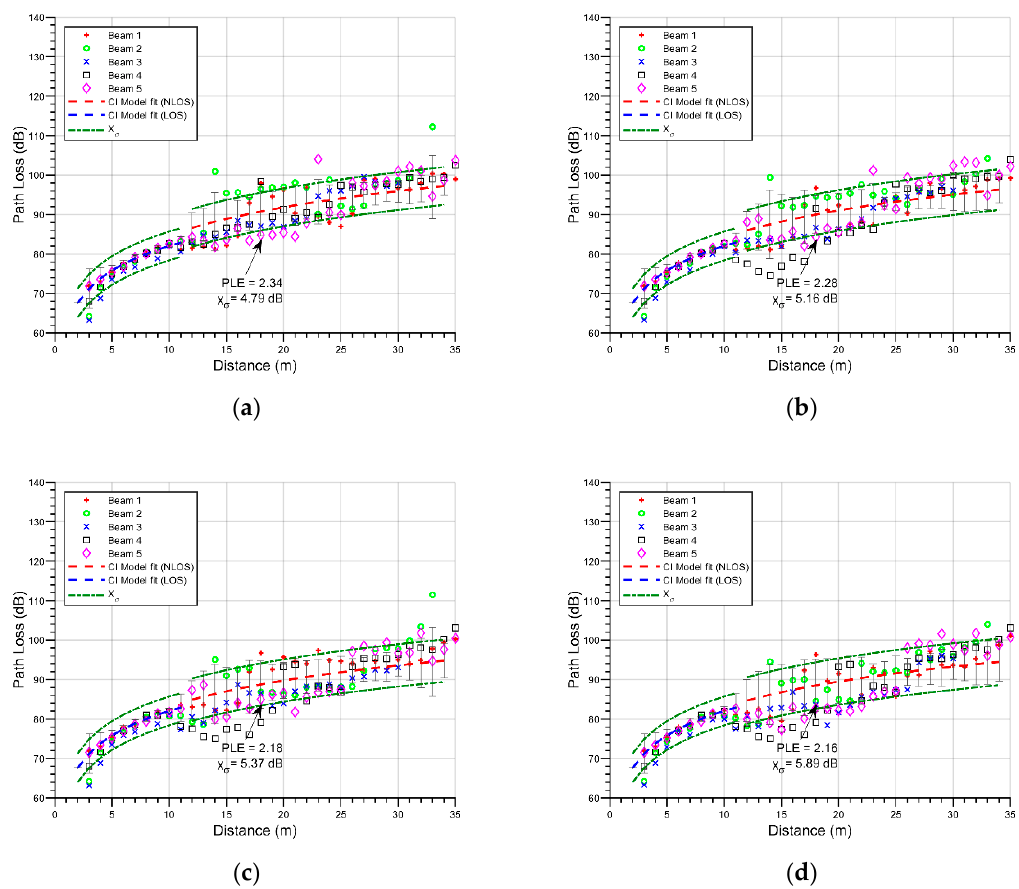
Figure 6. Path loss values for all beams and CI model fit: ( a ) 25% vehicle density scenario; ( b ) 50% vehicle density scenario; ( c ) 75% vehicle density scenario; ( d ) 100% vehicle density scenario.